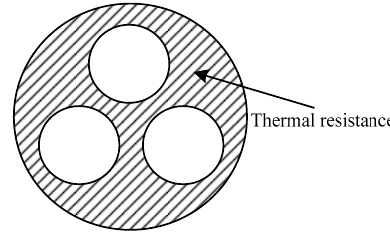
Figure 13. The irregular thermal resistance in literature [16,17].